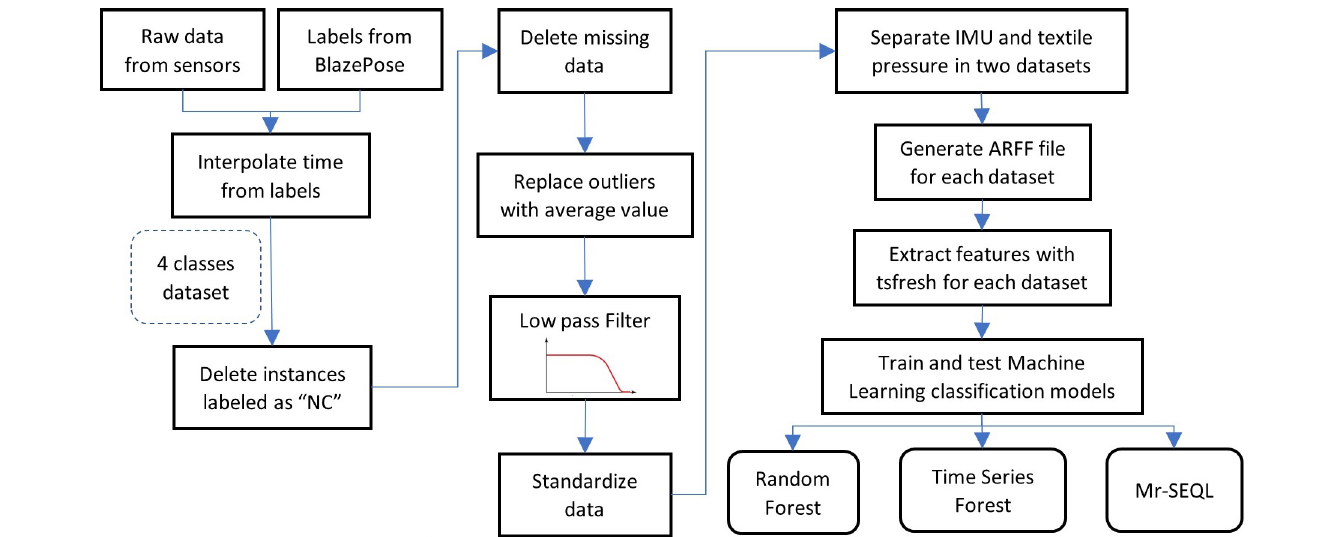
Figure 5. Workflow used to test and train the classification models from the raw data and the generated